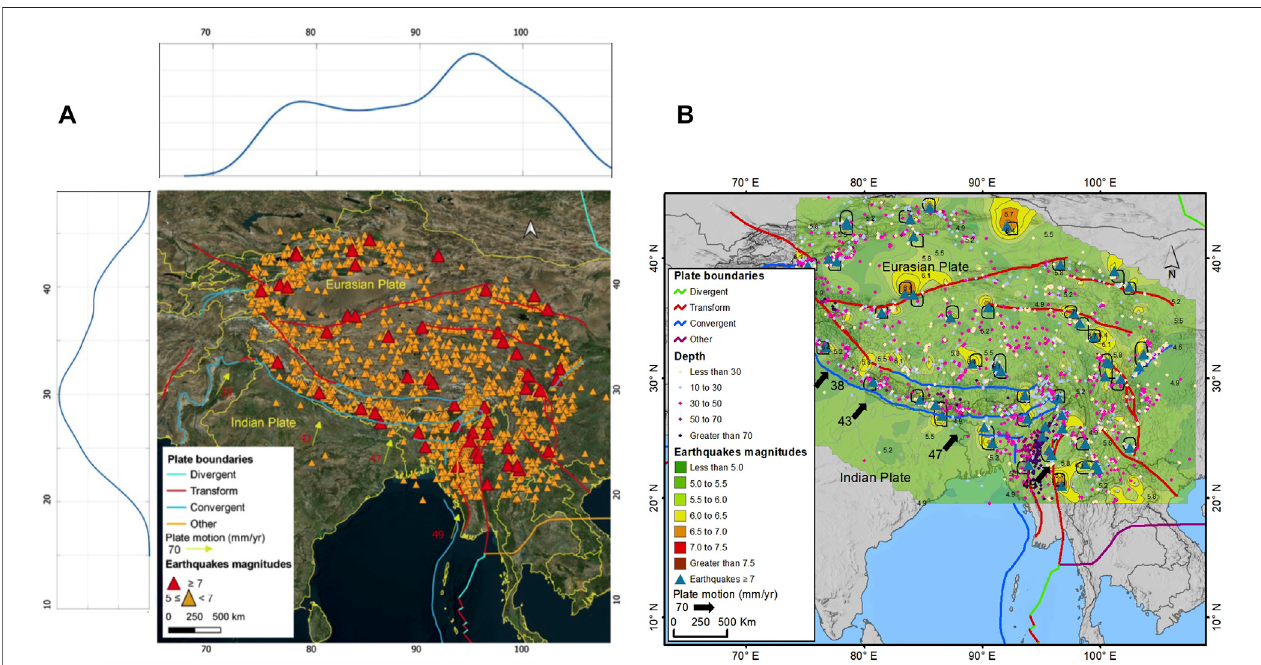
FIGURE 15 | Earthquakes in Southern China-Northern India. (A) Seismic activity between 1900 and 2021 is shown as yellow triangles for 5 ≤ earthquakes magnitudes < 7.Earthquakesmagnitudes ≥ 7aremarkedwithredtriangles.ThePDF(probabilitydensitydistribution)ofthelongitudeandlatitudeshowsthattheseismic zonehasbothabimodaldistribution,respectively.Platemotionvectors(rotatedbasedonthedirectionofplatemovement),platelimitsandearthquakesdataweretaken from the USGS. (B) Distribution of seismic hazards in Southern China-Northern India. The spatial probability of occurrence for 5 ≤ earthquakes magnitudes < 6 is shown in shades of green; for 6 ≤ earthquakes magnitudes < 7 is shown in shades of orange; and for earthquakes magnitudes ≥ 7 is shown in shades of